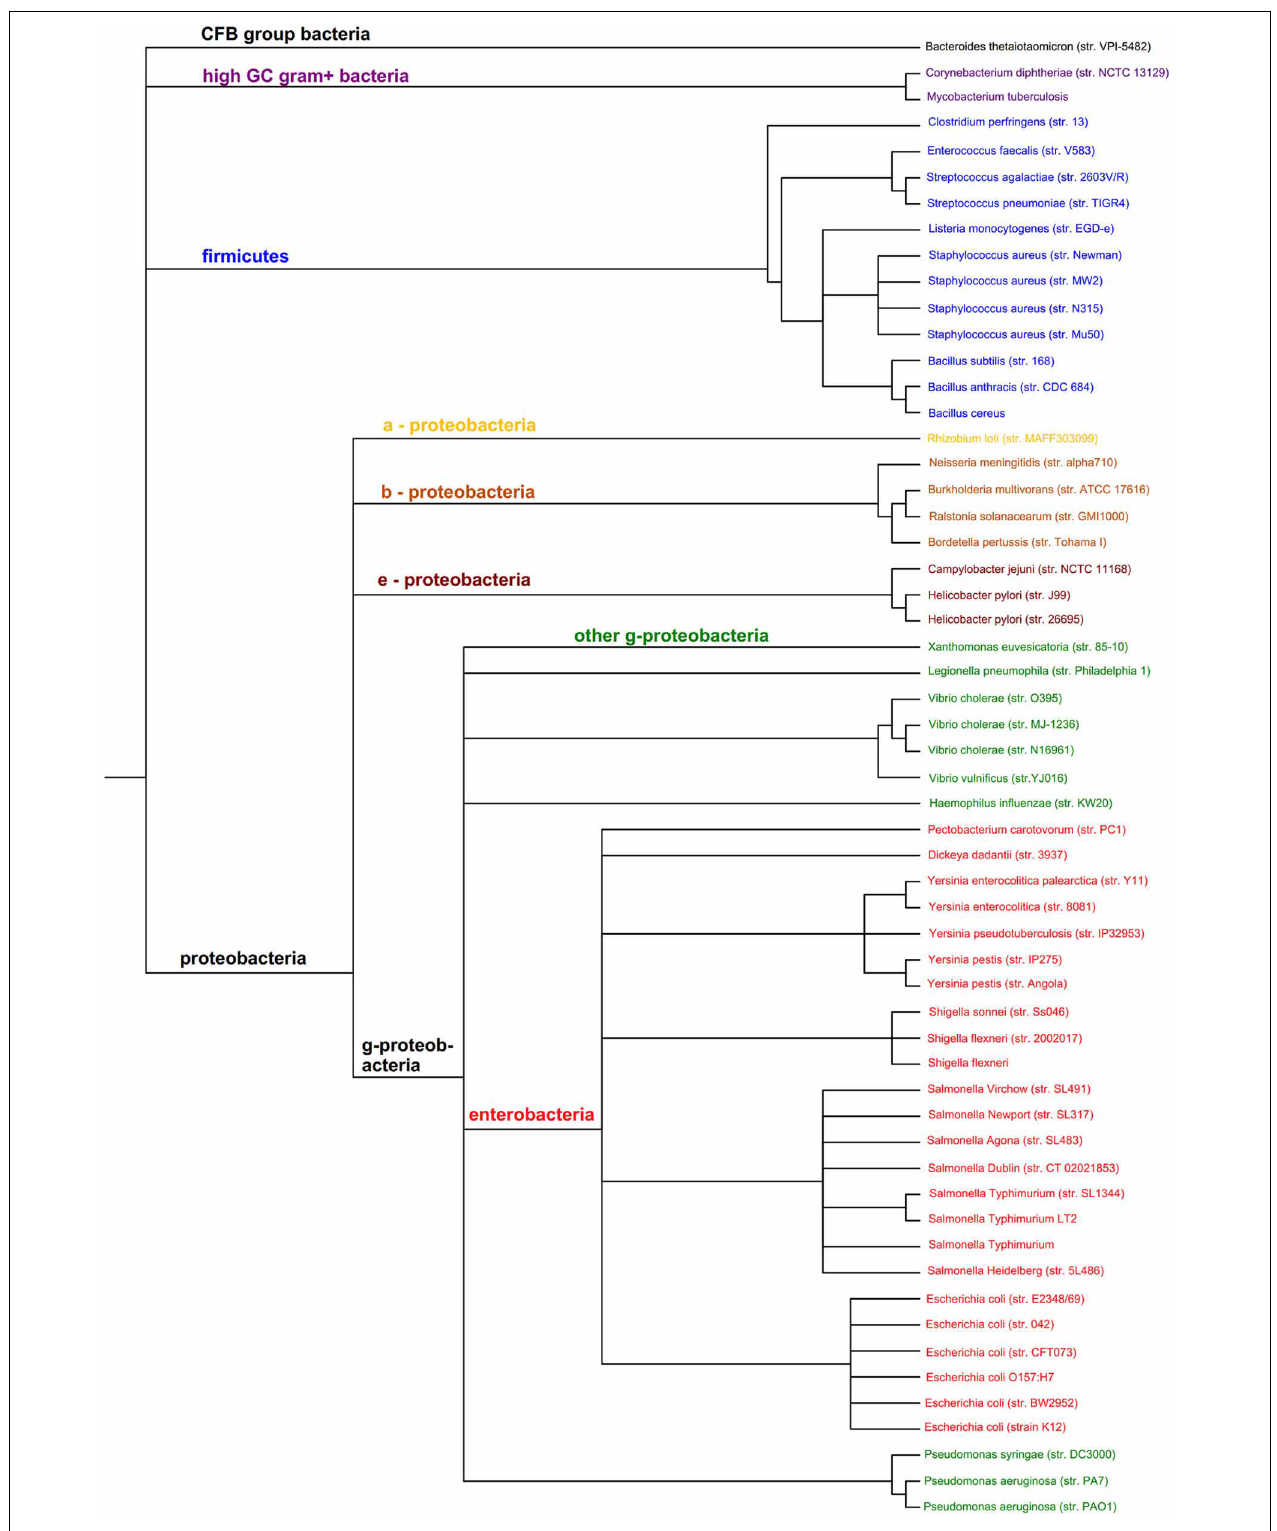
FIGURE 4 | Phylogenetic tree of the 60 organisms used to assess the distribution of prokaryotic protein motifs in Figures 2, 3. Purple, High GC Gram + bacteria; Blue, Firmicutes; Yellow, a-proteobacteria; Light Brown,